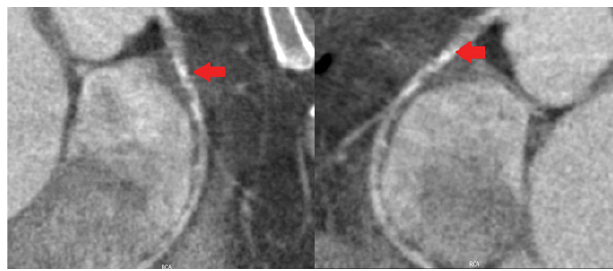
Fig. 4 – Coronary Right presents proximal and medium significant lesions. Filled arrows indicate injuries.